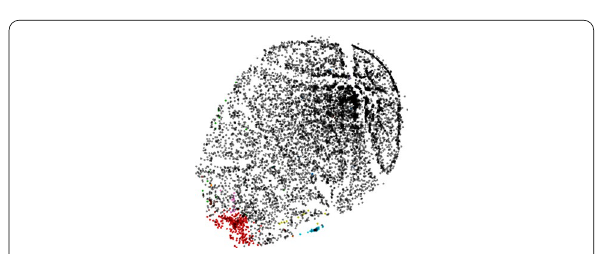
Fig. 3 feature distribution display via t-sne